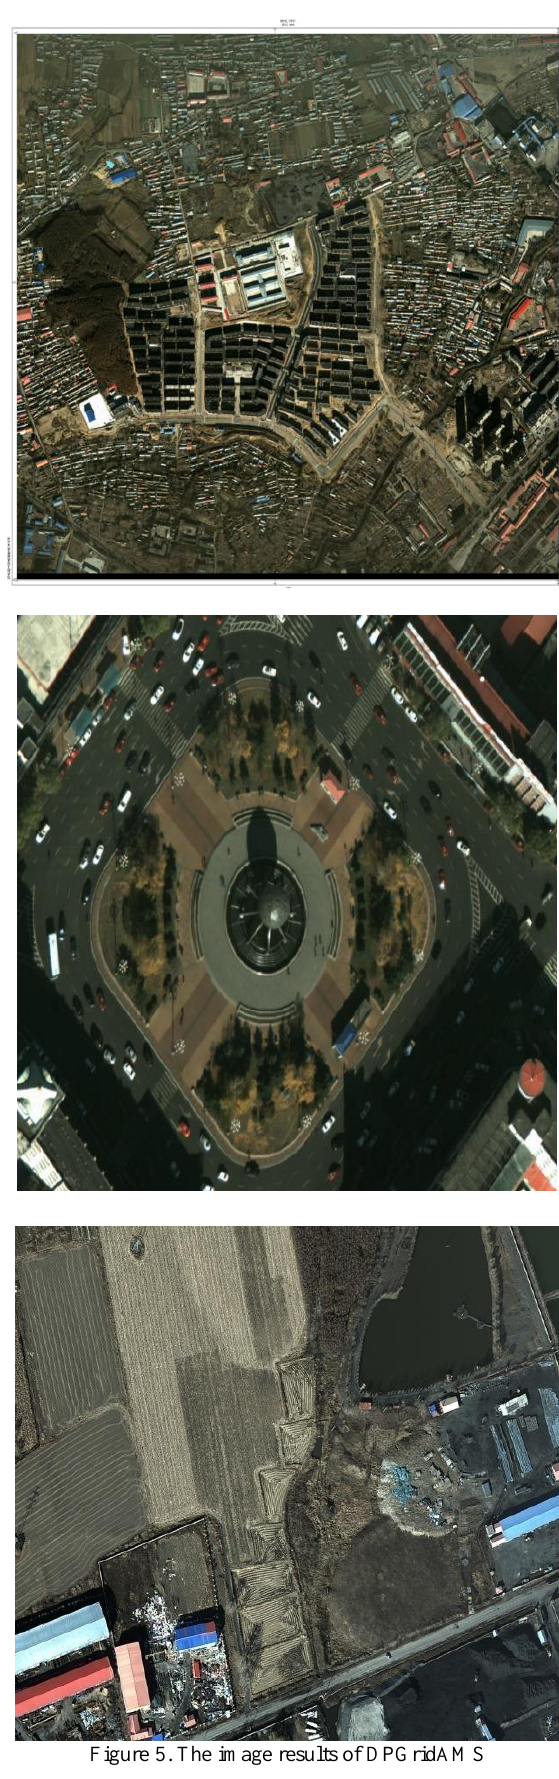
Figure 5. The image results of